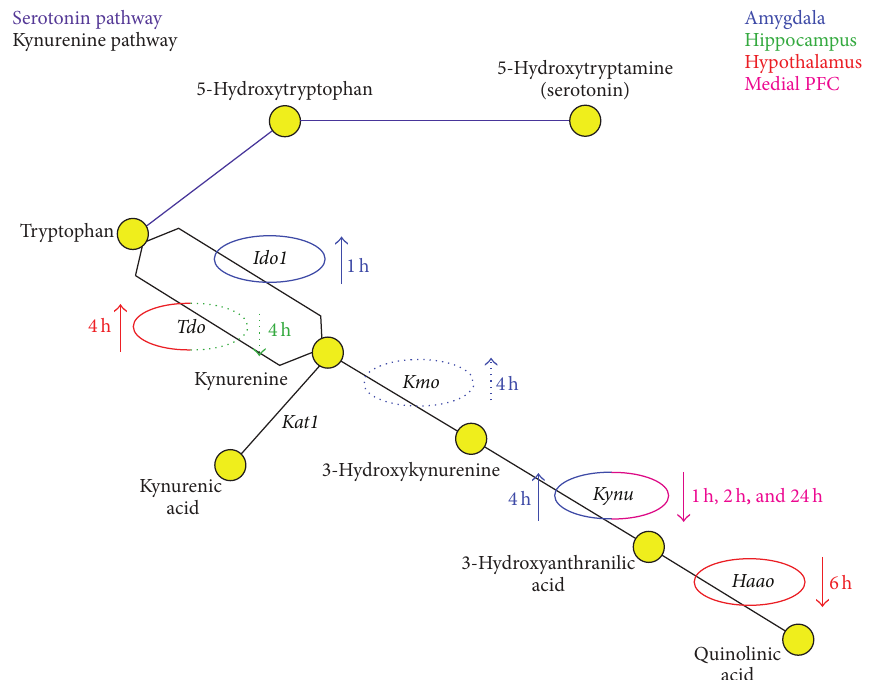
Figure 1: Schematic representation of tryptophan metabolism and its influence by stress. This figure shows the multiple ways that tryptophan can be metabolized. The classic, well-known pathway is its conversion to serotonin (purple). The primary pathway of tryptophan metabolism, however, is the kynurenine pathway (black), by which tryptophan is converted to kynurenine via tryptophan 2,3-dioxygenase (TDO) or indoleamine 2,3-dioxygenase 1 (IDO1). From there, it can be converted into the neuroprotective kynurenic acid (KNYA) via kynurenine aminotransferase (KAT1) or to quinolinic acid (QUIN) via a multistep process involving the enzymes kynurenine 3-monooxygenase (KMO), kynureninase (KYNU), and 3-hydroxyanthranilate 3,4-dioxygenase (3-HOA). An analysis of mRNA expression levels of tryptophan 2,3-dioxygenase ( Tdo ), indoleamine 2,3-dioxygenase 1 ( Ido1 ), kynurenine aminotransferase ( Kat1 ), kynurenine 3-monooxygenase ( Kmo ), kynureninase ( Kynu ), and 3-hydroxyanthranilate 3,4-dioxygenase ( Haao ) revealed increases in Ido1 , Kmo , and Kynu mRNA expression in the amygdala (blue), decreases in Tdo mRNA expression in the hippocampus (green), an upregulation of Tdo , and downregulation of Haao mRNA expression in the hypothalamus (red) and a downregulation of Kynu mRNA expression in the medial prefrontal cortex (pink) (solid lines indicate significant changes, while dashed lines indicate trending changes). This figure summates the regional and temporal effects of acute stress on the mRNA expression of kynurenine pathway